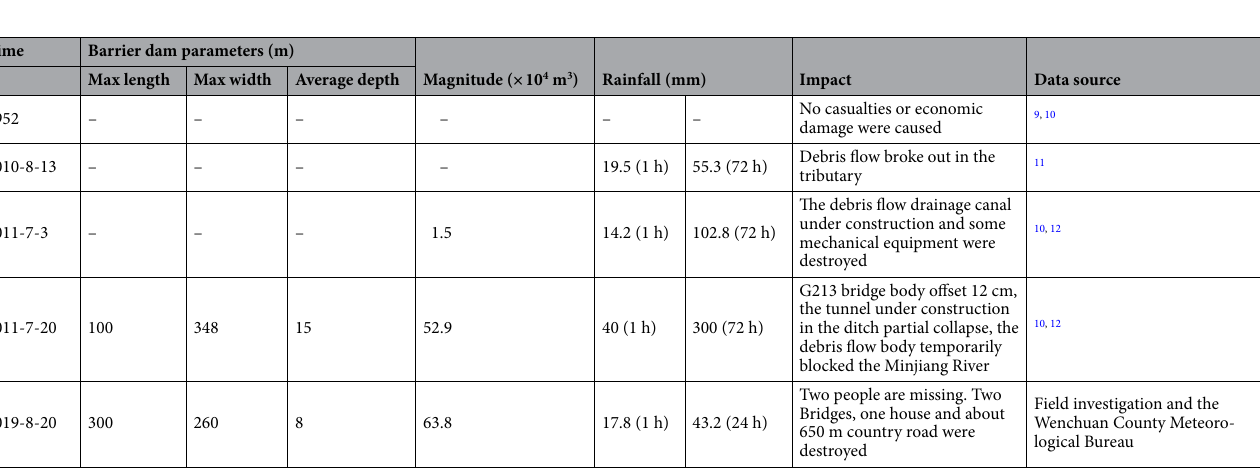
Figure 3. Drainage system and topography map of the Chediguan gully. Maps constructed using ArcGIS 10.2 (https:// deskt op. arcgis. com/ en/).